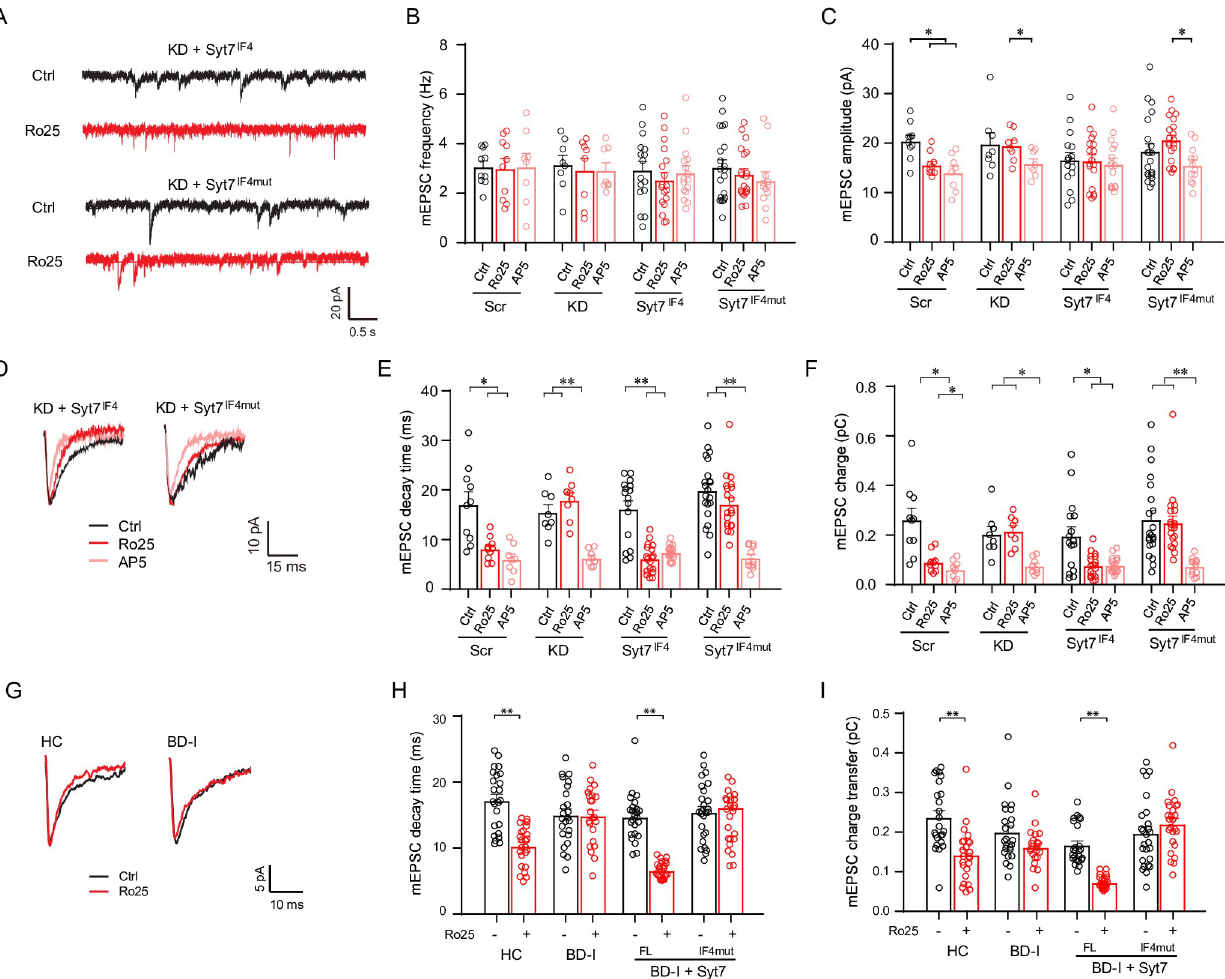
Fig 4. Human Syt7 variants induce deficits in spontaneous glutamate release and GluN2B activity. ( A ) Sample traces of AMPAR/NMDAR-mEPSCs in Syt7 KD neurons expressing Syt7 IF4 and Syt7 IF4mut . ( B, C ) Bar graphs summarizing the frequency ( B ) and amplitude ( C ) of mEPSCs. Scr, n = 10/10/8; Syt7 KD, n = 8/8/8; Syt7 IF4 , n = 16/18/16; Syt7 IF4mut , n = 21/20/12. ( D ) Average traces of AMPAR/NMDAR-mEPSCs. ( E, F ) Bar graphs summarizing the decay time ( E ) and total charge ( F ). ( G ) Average traces showing changes in the kinetics of AMPAR/NMDAR-mEPSCs in the iPSC-derived DG-like neurons of healthy controls and BD-I patients. ( H, I ) Bar graphs summarizing the decay time ( H ) and charge transfer ( I ) of AMPAR/NMDAR-mEPSCs in the HC neurons, BD-I neurons, and BD-I neurons overexpressing Syt7 FL or Syt7 IF4mut . For all groups, n = 23–26 neurons of 3 cell lines. Student t test; � P < 0.05; �� P < 0.001; error bars, SEM. The numerical data underlying this figure are included in S1 Data. AMPAR, AMPA receptor; BD-I, bipolar disorder I; DG, dentate gyrus; HC, healthy control; iPSC, induced pluripotent stem cell; KD, knockdown; mEPSC, miniature excitatory postsynaptic current; Syt7,